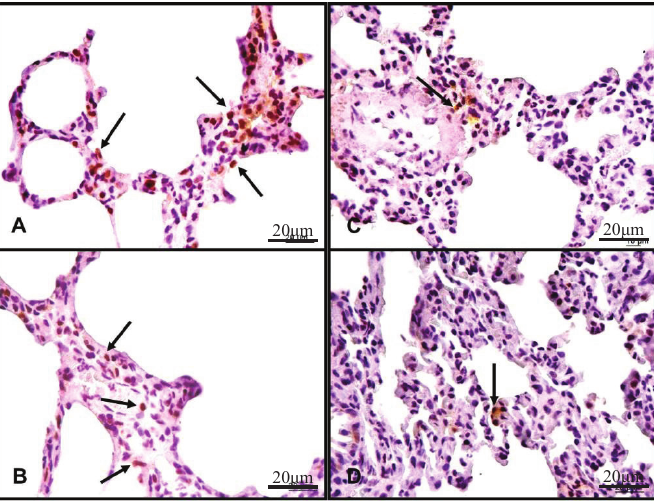
FIGURE 4 - Animals in the control group 24 hours ( A ) and 48 hours ( B ) have higher concentrations of thickened alveolar and reactive cells to caspase 3 (black arrows) indicative of apoptosis compared to NAC group 24 h ( C ) and 48 ( D ) (HE